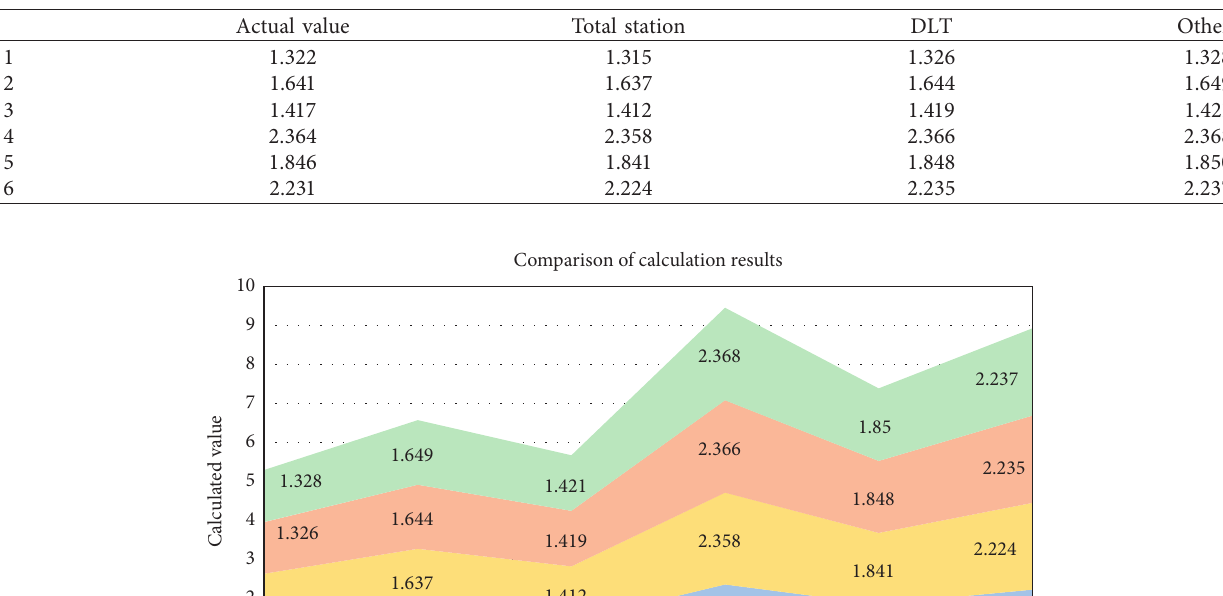
Figure 5: Accuracy statistics of measurement points. Table 6: Comparison table of calculation results of different methods.